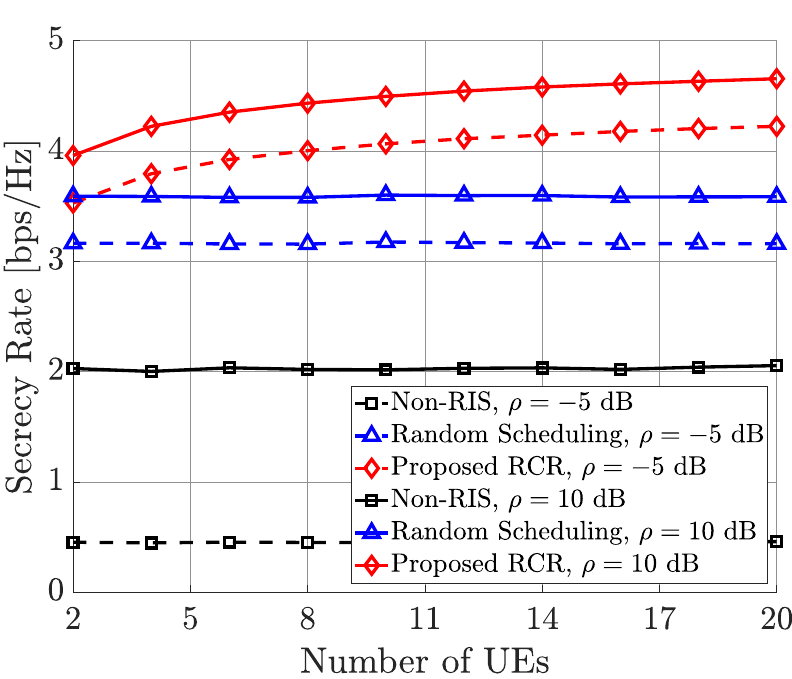
Figure 4. Secrecy rate performance according to number of UE.